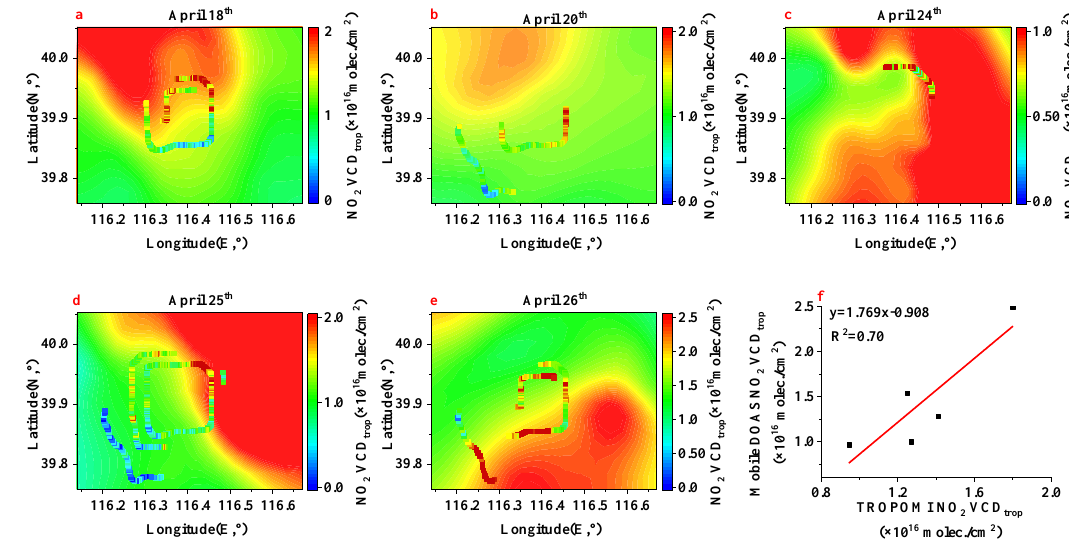
Figure 7. ( a – e ) are the mobile-DOAS and satellite tropospheric NO 2 VCD spatial distribution; ( f ) is the correlation coefficient (R 2 ).